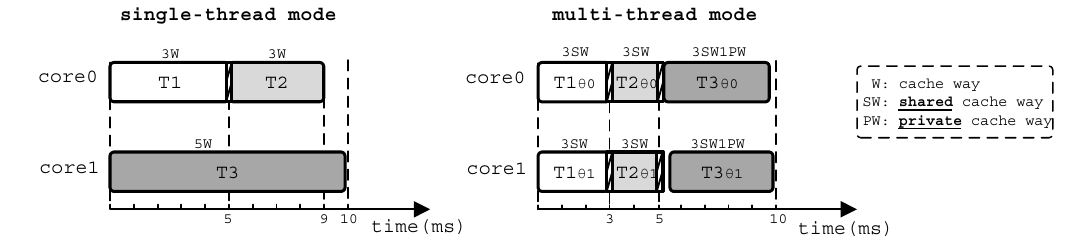
Figure 4. Scheduling in single-thread and multi-thread modes.